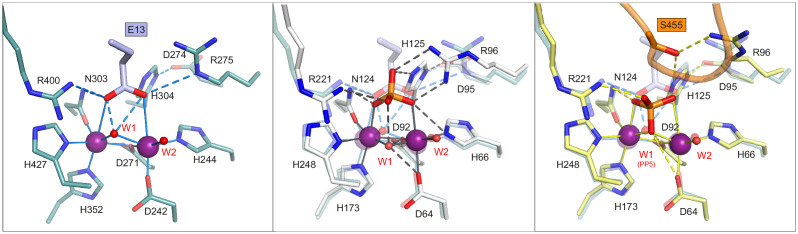
Comparison of the PP5-Cdc37(S13E), Phactr1/PP1 and Phactr1/PP1-IRSp53 structures gives insight into catalytic mechanism.Left, stick representation of molecular interactions at the catalytic site of PP5-Cdc37(S13E). Centre, superposition of the PP5-Cdc37(S13E) (lilac) and Phactr1/PP1 complex (white) catalytic sites. Note the coincidence of the PP5-Cdc37(S13E) phosphomimetic glutamate with the oxygens of the phosphate present in the Phactr1/PP1 complex. Right, comparison of the PP5-Cdc37(S13E) and Phactr1/PP1-IRSp53 complexes (yellow). Note the inversion of the phosphate and the absence of W1.